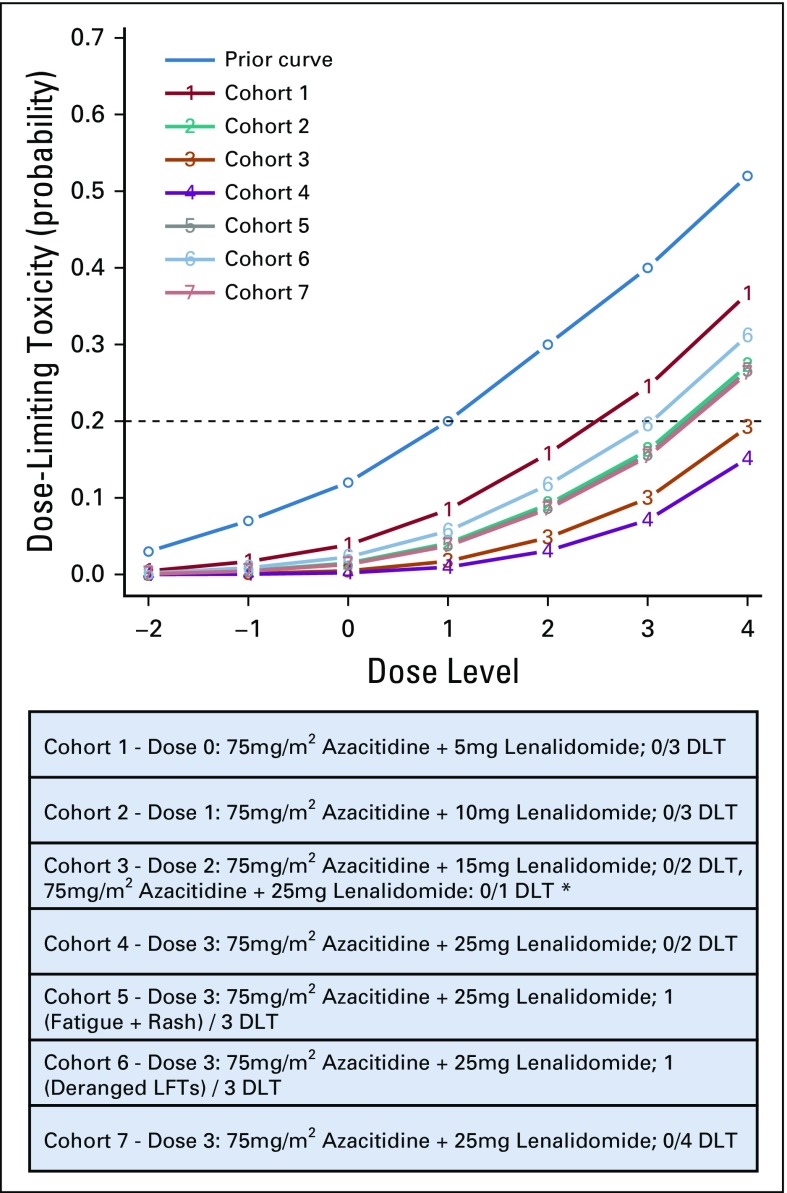
Continual reassessment model dose-toxicity curves. This figure shows how the estimates of the probabilities of dose-limiting toxicities (DLTs) at each dose evolve from the initial guesses of DLT (prior curve) to the final cohort 7. The dose-toxicity curves initially dropped from cohorts 1 to 4 (because no DLT was observed at all tested doses) and only increased when DLTs were observed for cohorts 5 and 6 at 25 mg lenalidomide. (*) One patient was incorrectly treated with dose level 3 in cycle 1.